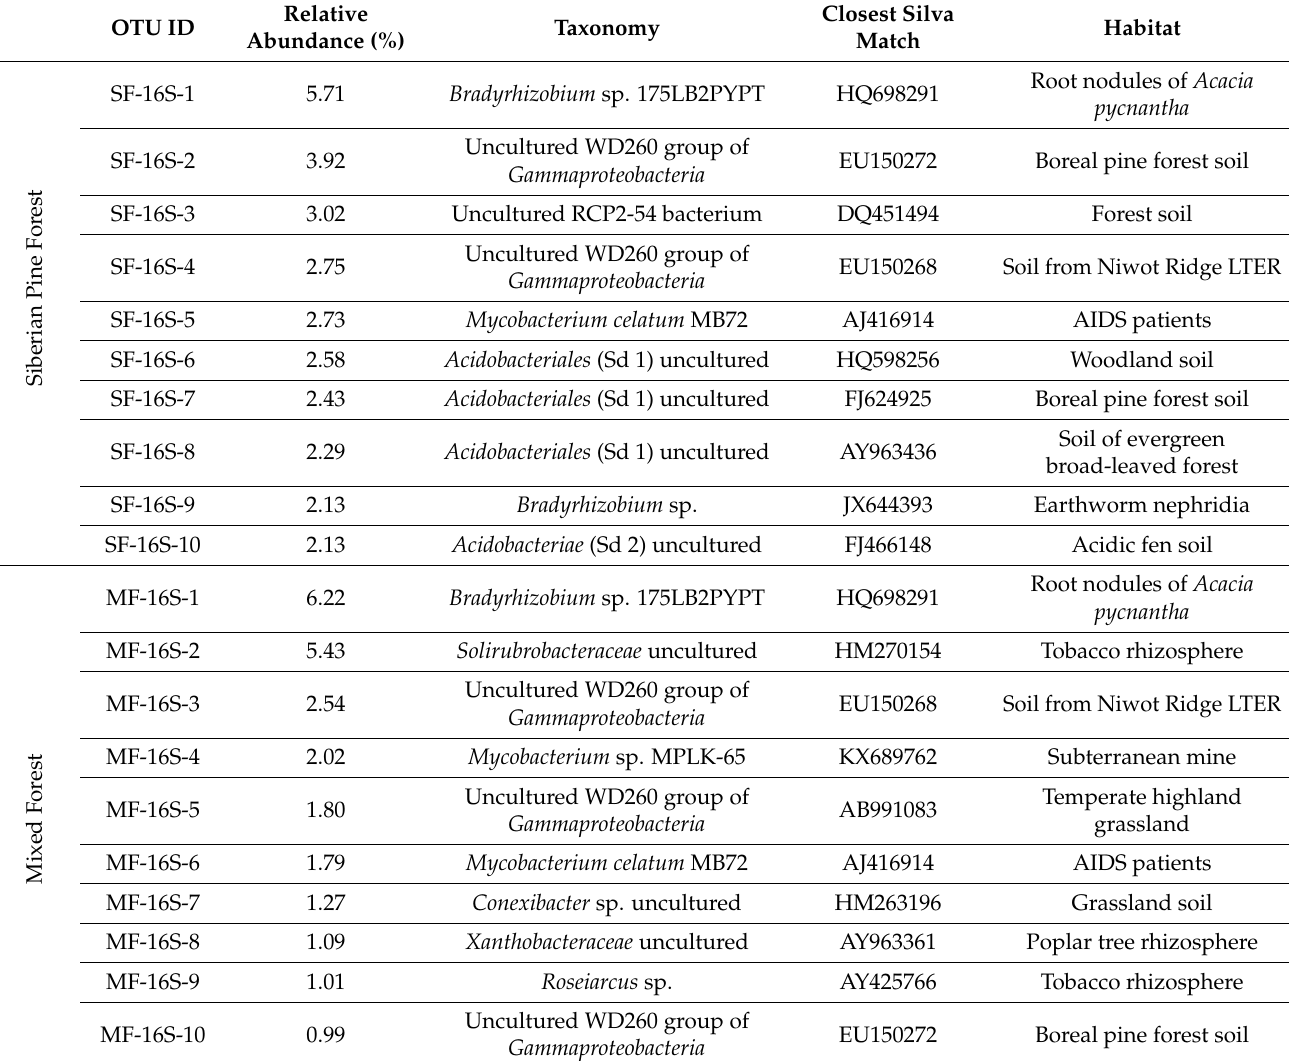
Table 3. Major operational taxonomic units (OTUs) of 16S rRNA gene sequences revealed in the three forest